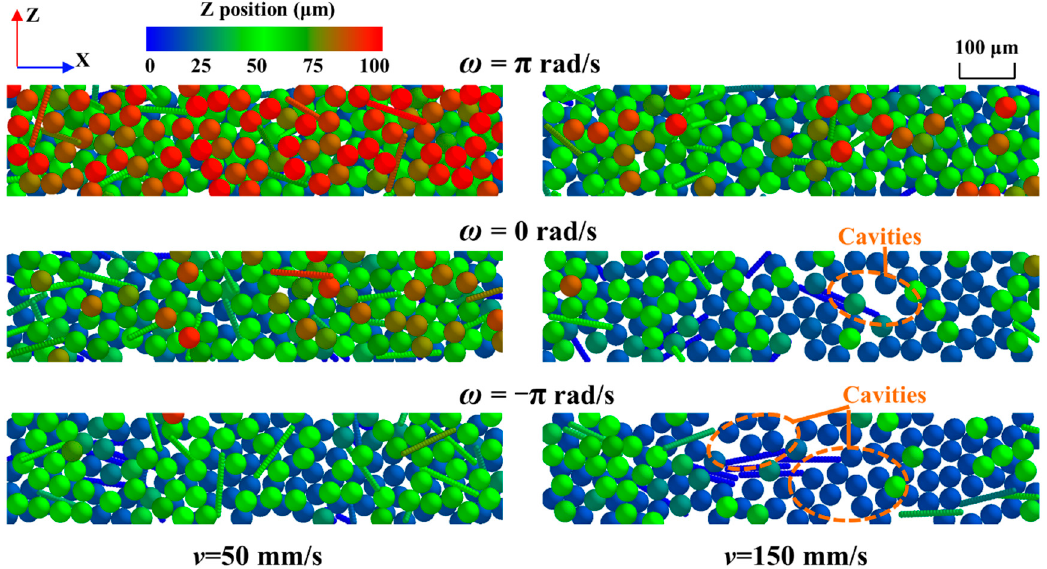
Figure 4. Surface morphology of the powder bed under different roller rotation patterns.